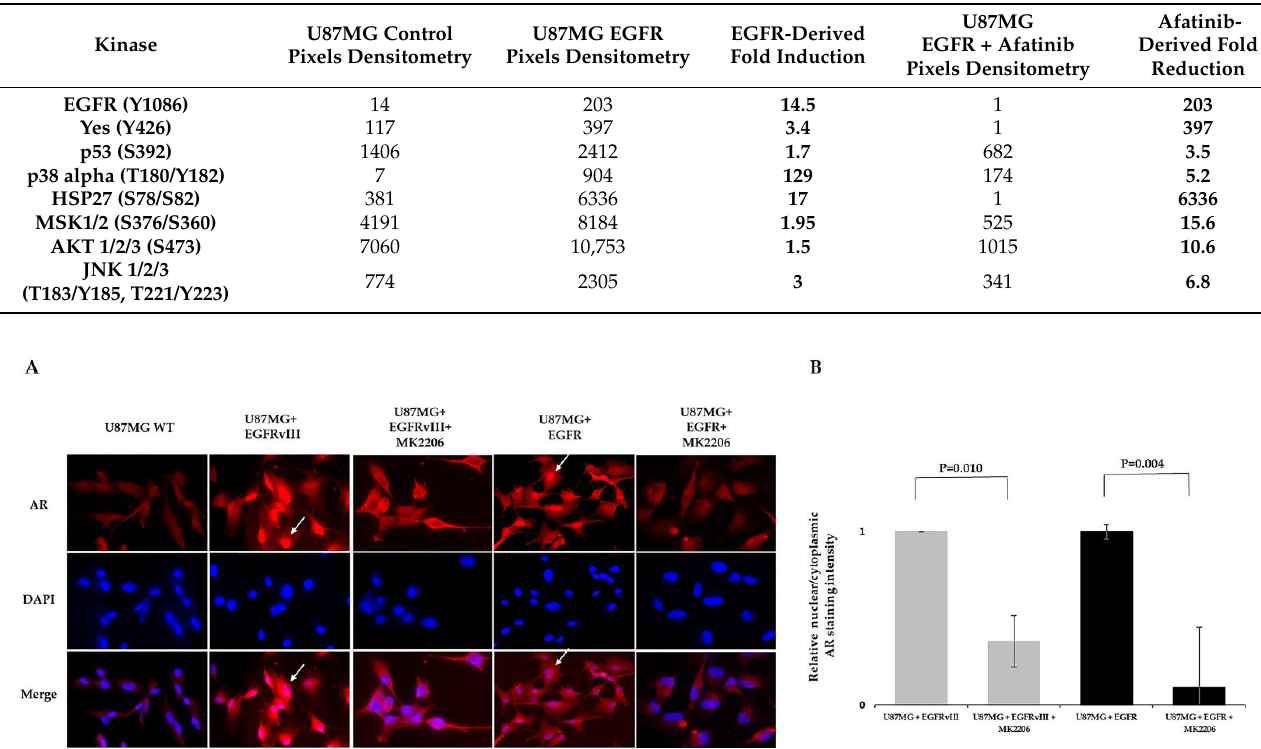
Figure 4. AKT inhibitor modulates EGFR-induced AR expression and nuclear translocation in the U87MG glioblastoma cell line model. ( A ) Immunofluorescence staining of AR in U87MG subclones following treatment with AKT kinase inhibitor. Immunofluorescence staining of anti-AR (D6F11) (red) in U87MG WT EGFR or EGFRvIII following 6 h treatment with vehicle or 5 µm MK2206. DAPI staining indicates the location of the nucleus (blue). Cell nuclei were stained with DAPI (blue). White arrows indicate AR nuclear staining. ( B ) Relative AR nuclear localization was determined by quantification of the relative fluorescent intensity ratio between nuclear and cytosolic compartments using ImageJ software. The results are expressed as mean ± SD following normalization to the vehicle-treated subclones, p -values between the groups are indicated.